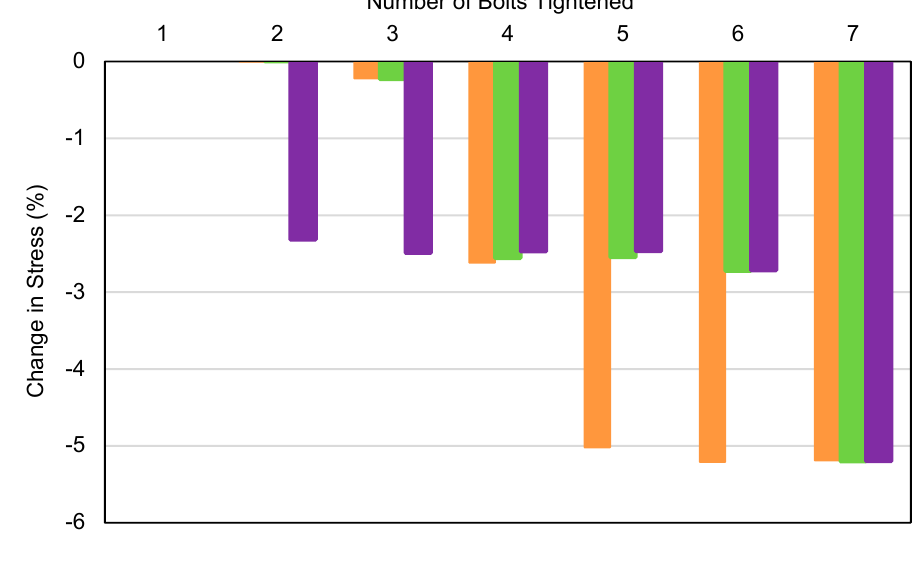
Figure 9. Comparison of bolt Fp using three different tightening sequences .